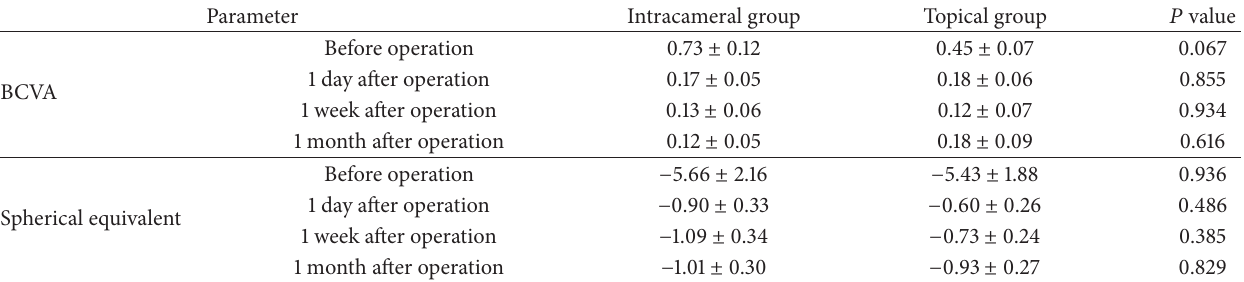
Table 4: The best corrected visual acuity (BCVA, in LogMAR) and spherical equivalent (D) in the two groups (mean ± SD).